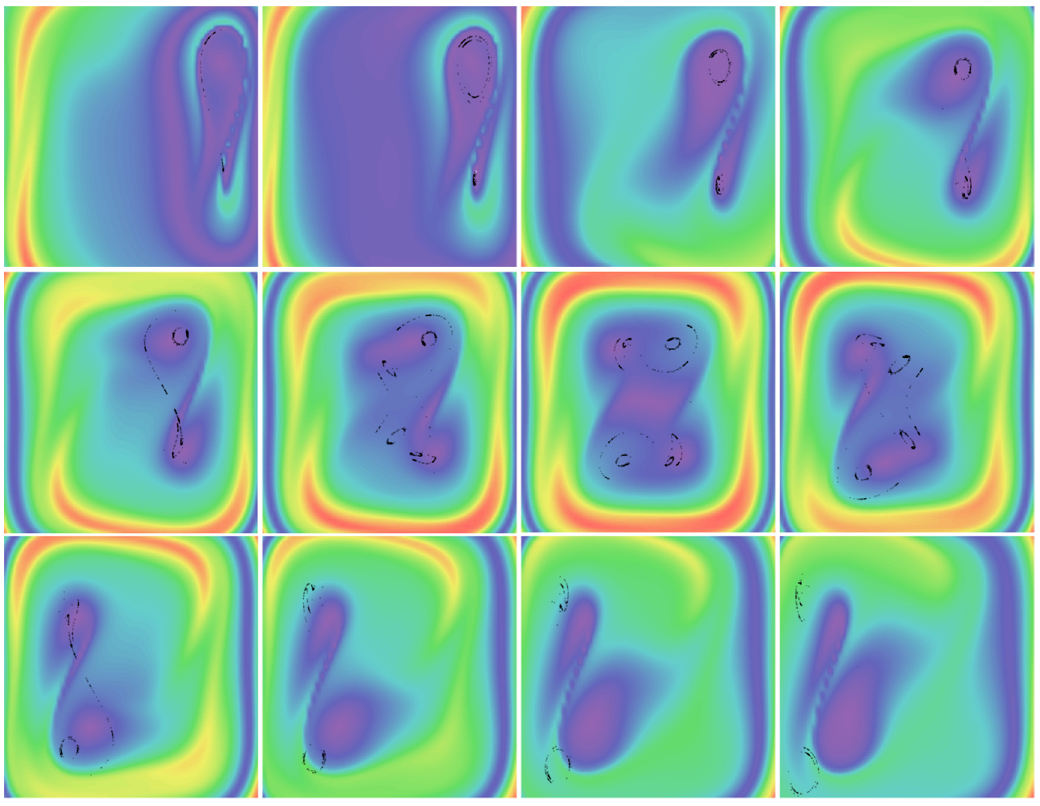
Figure 3. Kinetic energy calculated in horizontal slices of state space (from left to right, up to down) and return maps (black dots): z = − 13, z = − 10, z = − 6, z = − 3, z = − 2, z = − 1, z = 0, z = 1, z = 2, z = 3, z = 4, and z = 5.